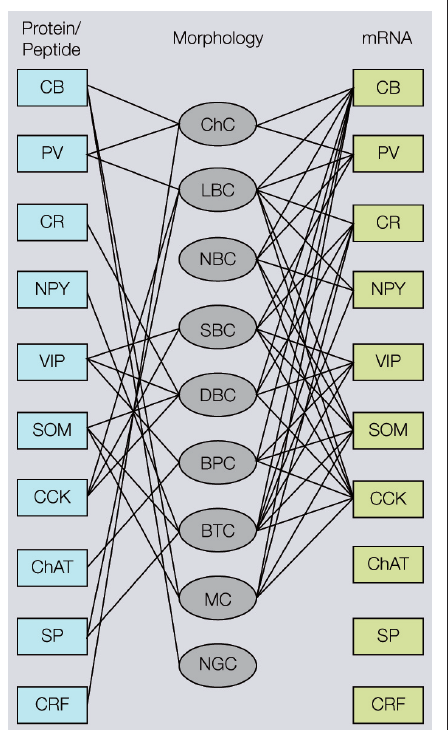
Figure 3 | Associations of molecular (protein, mRNA) and morphological properties of interneurons. Left side: Immunocytochemical expression of commonly used markers [i.e., calbindin (CB), parvalbumin (PV), calretinin (CR), neuropeptide Y (NPY), vasointestinal polypeptide (VIP), somatostatin (SOM), cholecystokinin (CCK), choline acetyltransferase (ChAT), substance P (SP) corticotropin releasing factor (CRF)] in different morphological types of interneurons [i.e., chandelier cells (ChC), large basket cells (LBC), nest basket cells (NBC), small basket cells (SBC), bipolar cells (BPC), bitufted cells (BTC), Martinotti cells (MC), neurogliaform cells (NGC)]. Right side: mRNAs expression in different types of interneurons. Notice that most substances are coexpressed in multiple cell types and that the overlap in mRNA expression is much more extensive than immunostaining, suggesting that antibody staining is a more discriminating classification tool. Thus, genotypic and phenotypic molecular classification schemes are not